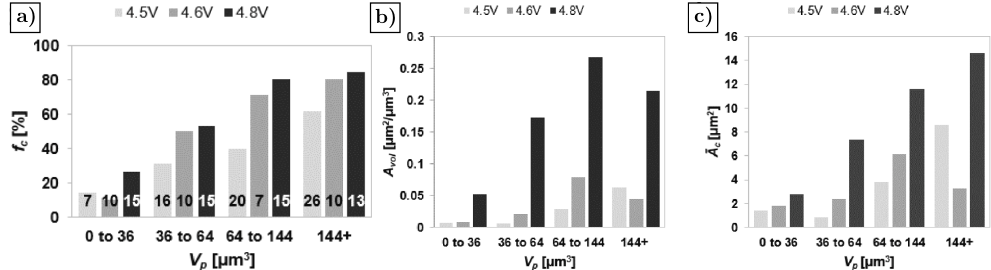
Figure 32. ( a ) The percentage of LCO particles within a given volume range that contains cracks after a single charge cycle to a given cutoff voltage. ( b ) The crack area per unit of volume for particles within a given volume range after a single charge cycle to a given cutoff voltage. ( c ) The average individual crack area (proportional to crack length) for particles within a given volume range after a single charge cycle to a given cutoff voltage. Reprinted with permission by Elsevier from [137], Copyright